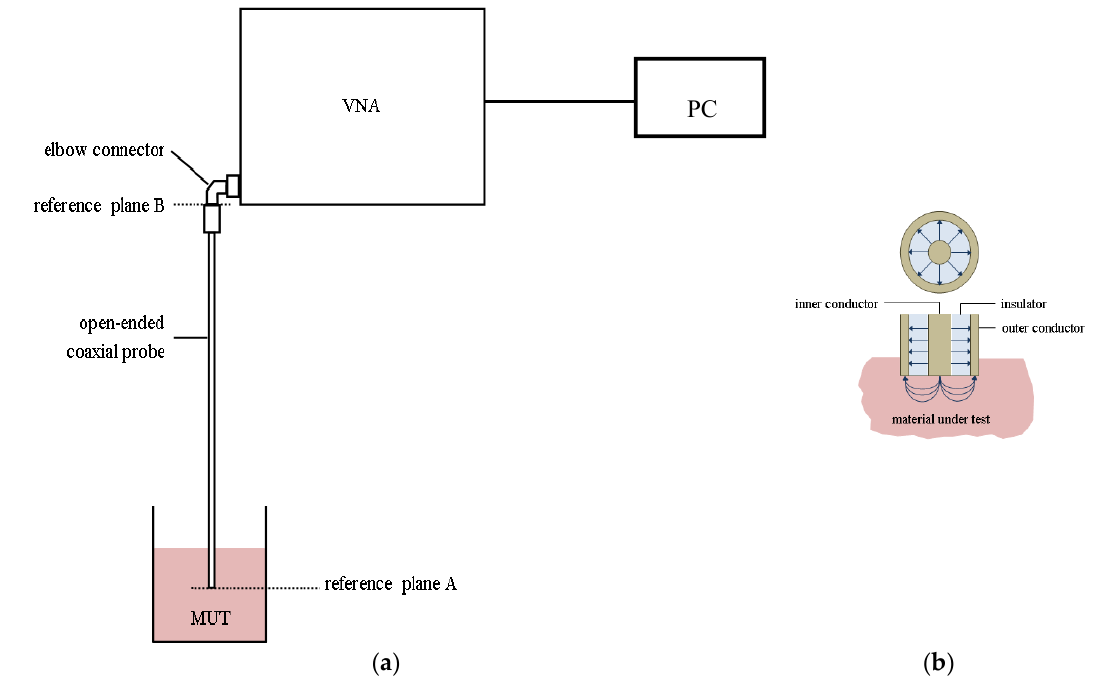
Figure 1. Open-ended coaxial probe technique: ( a ) Schematic of the measurement set-up, showing the vector network analyser (VNA) test port connected to the coaxial probe via an elbow connector, and the material under test (MUT); ( b ) cross-sections of the coaxial probe open end, showing the electric field configuration inside the coaxial line and the fringing fields protruding into the MUT.